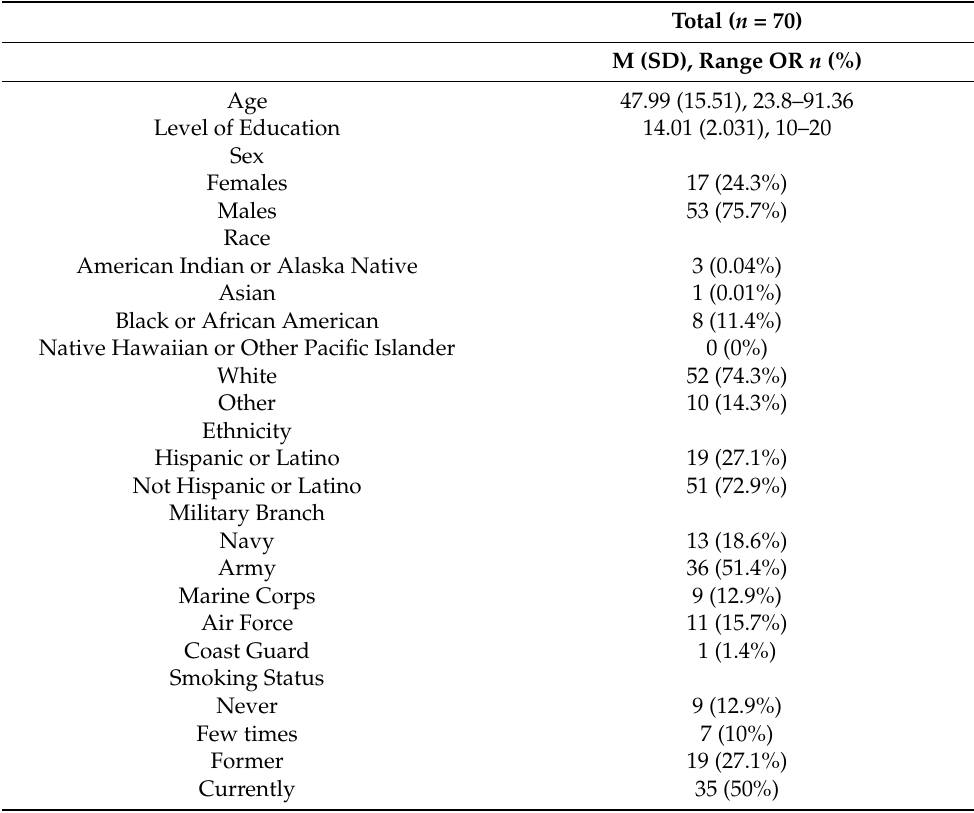
Table 1. Demographic